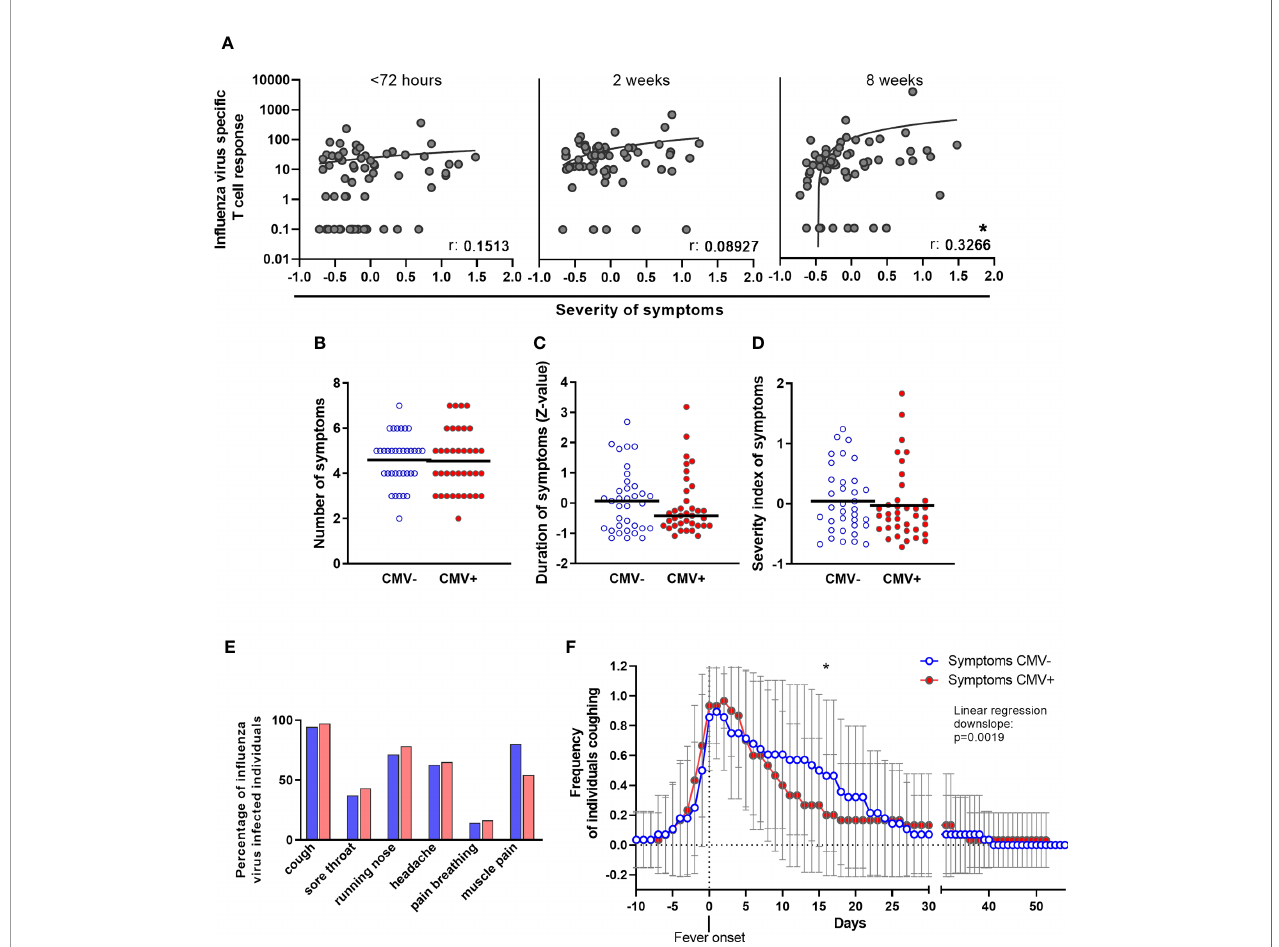
FIGURE 5 | No negative effect of CMV-infection on number and duration of symptoms of in fl uenza virus infection in older adults. (A) IAV-speci fi c T-cell responses upon in fl uenza virus infection at < 72 hours after fever onset, and 2 and 8 weeks later was associated with the severity of symptoms of in fl uenza infection. Association was tested by Spearman correlation . (B) Number of symptoms during in fl uenza virus infection in CMV - and CMV + individuals. Due to study design, participants had a minimal of two symptoms; fever ( ≥ 37.8°C) and at least 1 other symptom. Statistical differences between CMV - and CMV + were tested by c - square test. (C) Duration of having symptoms, regardless which one and how many, of in fl uenza virus infection in CMV - and CMV + individuals. Duration in days was calculated to Z-values. Difference between CMV - and CMV + individuals was tested by student-t test. (D) Severity of symptoms, taking along both duration and number of symptoms was assessed by taking the mean of Z-values of the six symptoms (cough, sore throat, runny nose, headache, pain while breathing or muscle pain). (E) Percentage of CMV - and CMV + individuals suffering from one of the six symptoms. Statistical differences between CMV - and CMV + were tested by c - square test and corrected for multiple testing by Bonferroni correction. (F) Frequency of CMV - and CMV + individuals coughing during in fl uenza virus infection. Difference between CMV - and CMV + individuals was tested by linear regression analysis on the downslope (starting at day of fever onset, day 0 on the x-axis) and comparison of the slope of CMV - individuals and CMV + individuals. *P <